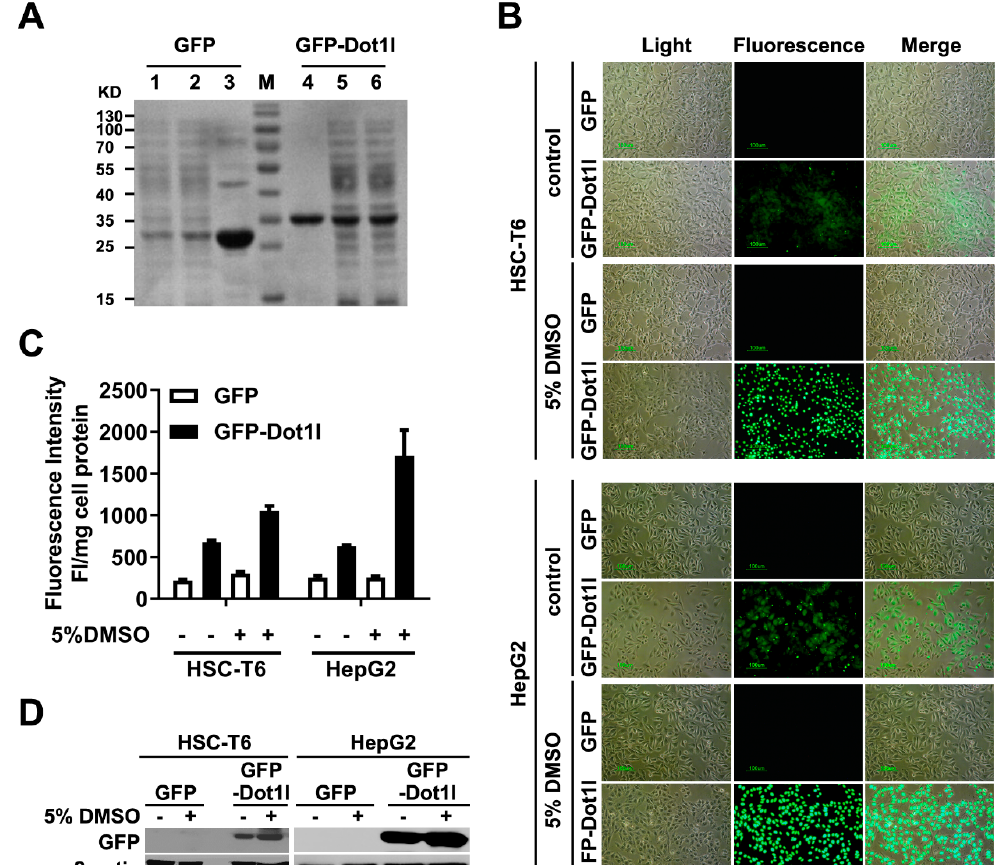
Figure 7. ( A ) Coomassie Brilliant Blue-stained SDS-PAGE of GFP-Dot1l fusion protein produced by recombinant prokaryotic expression system. Lanes 1 and 6 indicate no isopropyl- β -D- thiogalactopyranoside (IPTG) induction, lanes 2 and 5 indicate IPTG induction, lanes 3 and 4 indicate purified protein. ( B ) Fluorescence microscopy of purified GFP and GFP-Dot1l protein delivery in HSC-T6 and HepG2 cells with or without DMSO pretreatment. ( C ) Fluorescence intensity Supplementary Figure S1F (top panel indicates HSC-T6, bottom panel indicates HepG2). ( D ) GFP and GFP-Dot1l protein in the cytosol of HSC-T6 and HepG2 cells examined by Western blotting; anti-GFP antibody was used to detect the protein. Cell lysate fluorescence intensity was adjusted by protein concentration examined by bicinchoninic acid (BCA)